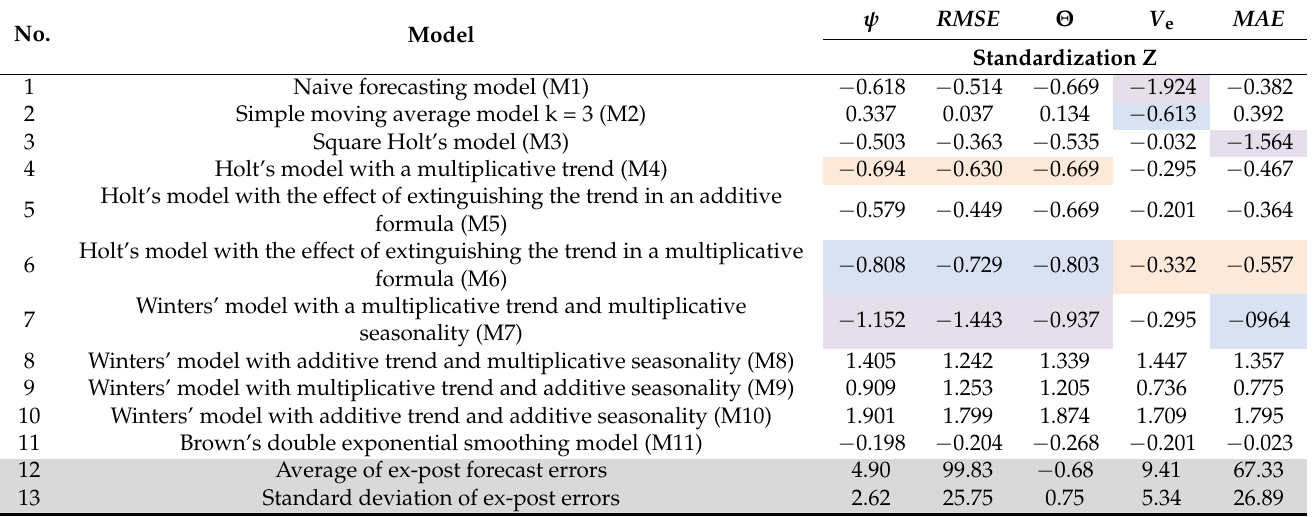
Ranking minimization: designation in Table 6. Description: range 1